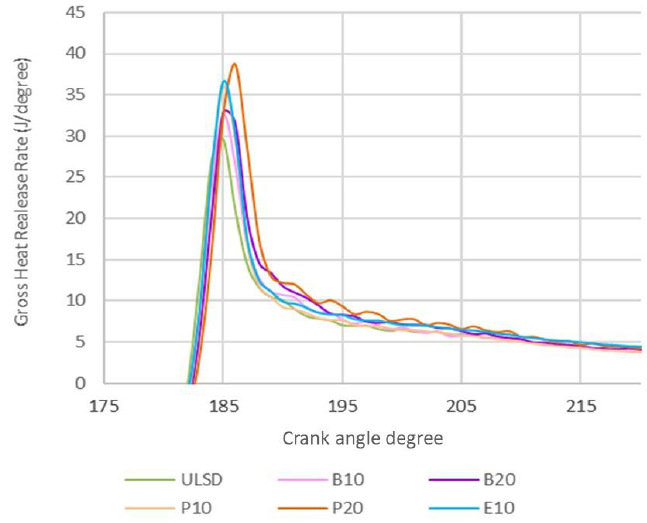
Figure 7. Sound pressure level (SPL) for alcohol/diesel fuel blends; 10% ( v / v ) ethanol/diesel fuel (E10), 10% ( v / v ) propanol/diesel fuel (P10), 20% ( v / v ) propanol/diesel fuel (P20), 10% ( v / v ) buta- nol/diesel fuel (B10), 20% ( v / v ) butanol/diesel fuel (B20) and 100% ultra-low -sulfur diesel fuel (USLD).